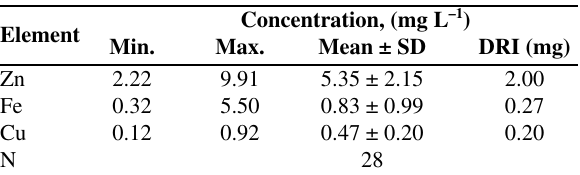
Table 8. Descriptive analysis of for Zn, Fe and Cu in human milk samples Element